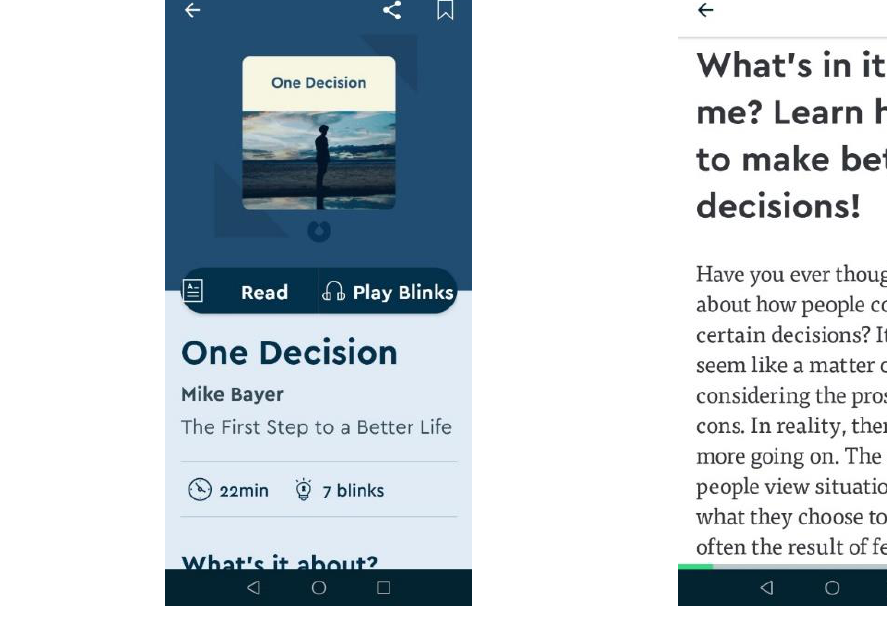
Figure 1. An illustration of the mobile app [23]. Figure 2. An illustration of the mobile app articles